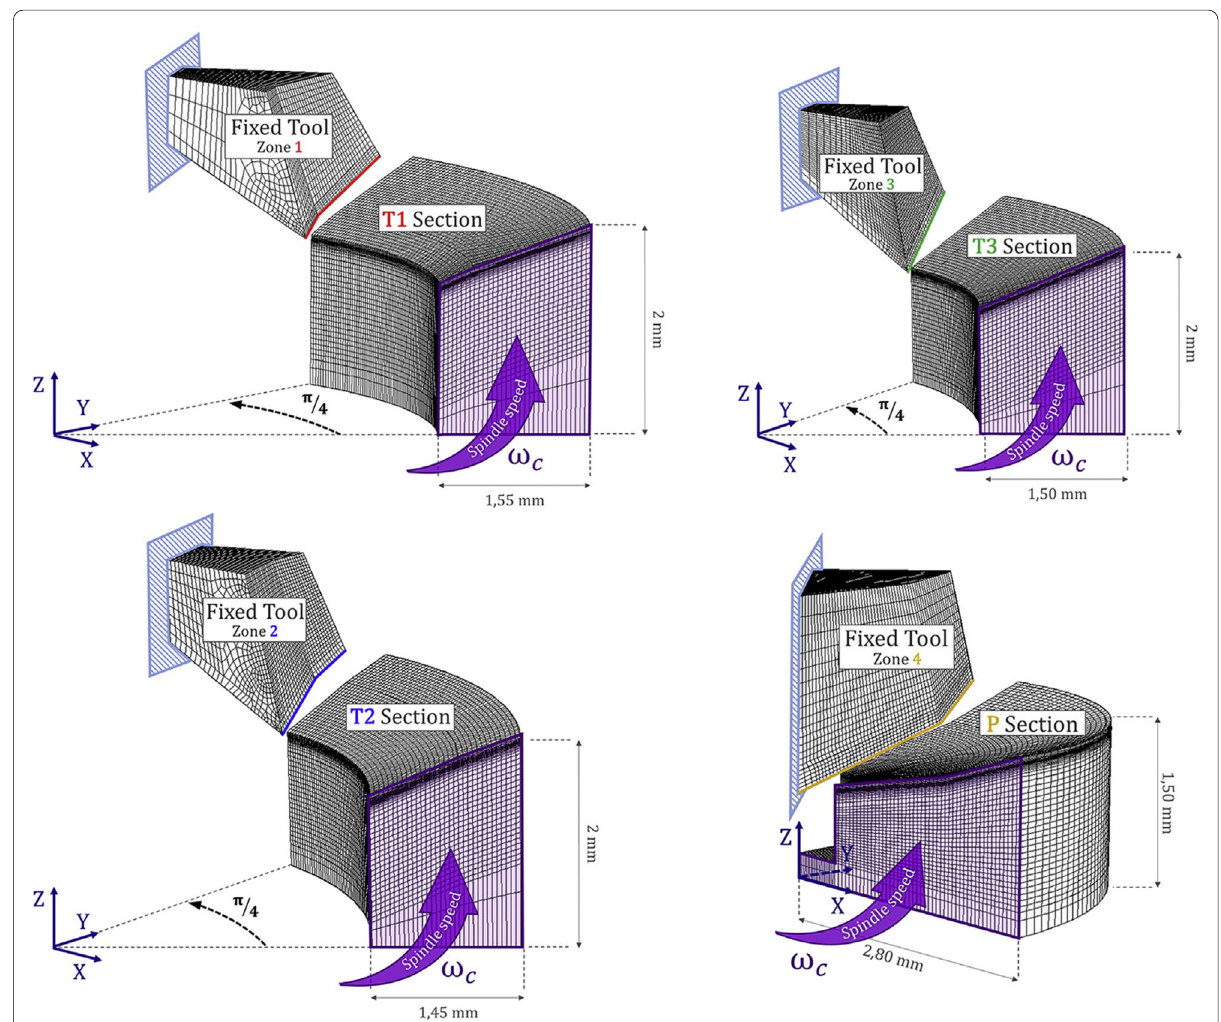
Figure 2 A multi-scale and coupled cutting model for the drilling of Ti6Al4V